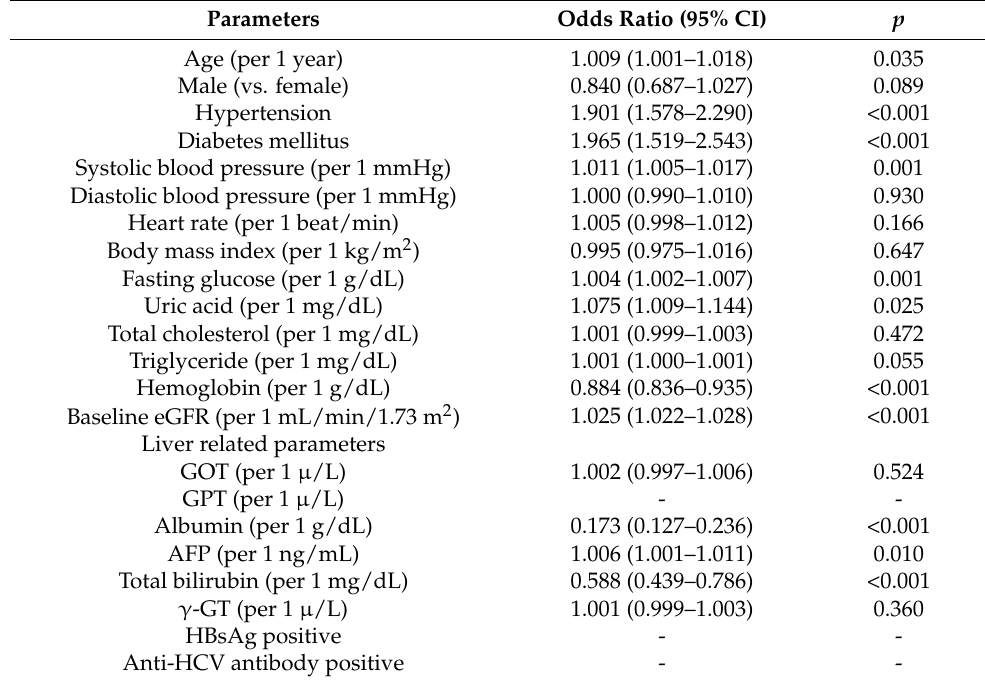
Table 3. Parameters associated with an eGFR decline of ≥ 25% in multivariate binary logistic analysis in all study participants ( n =